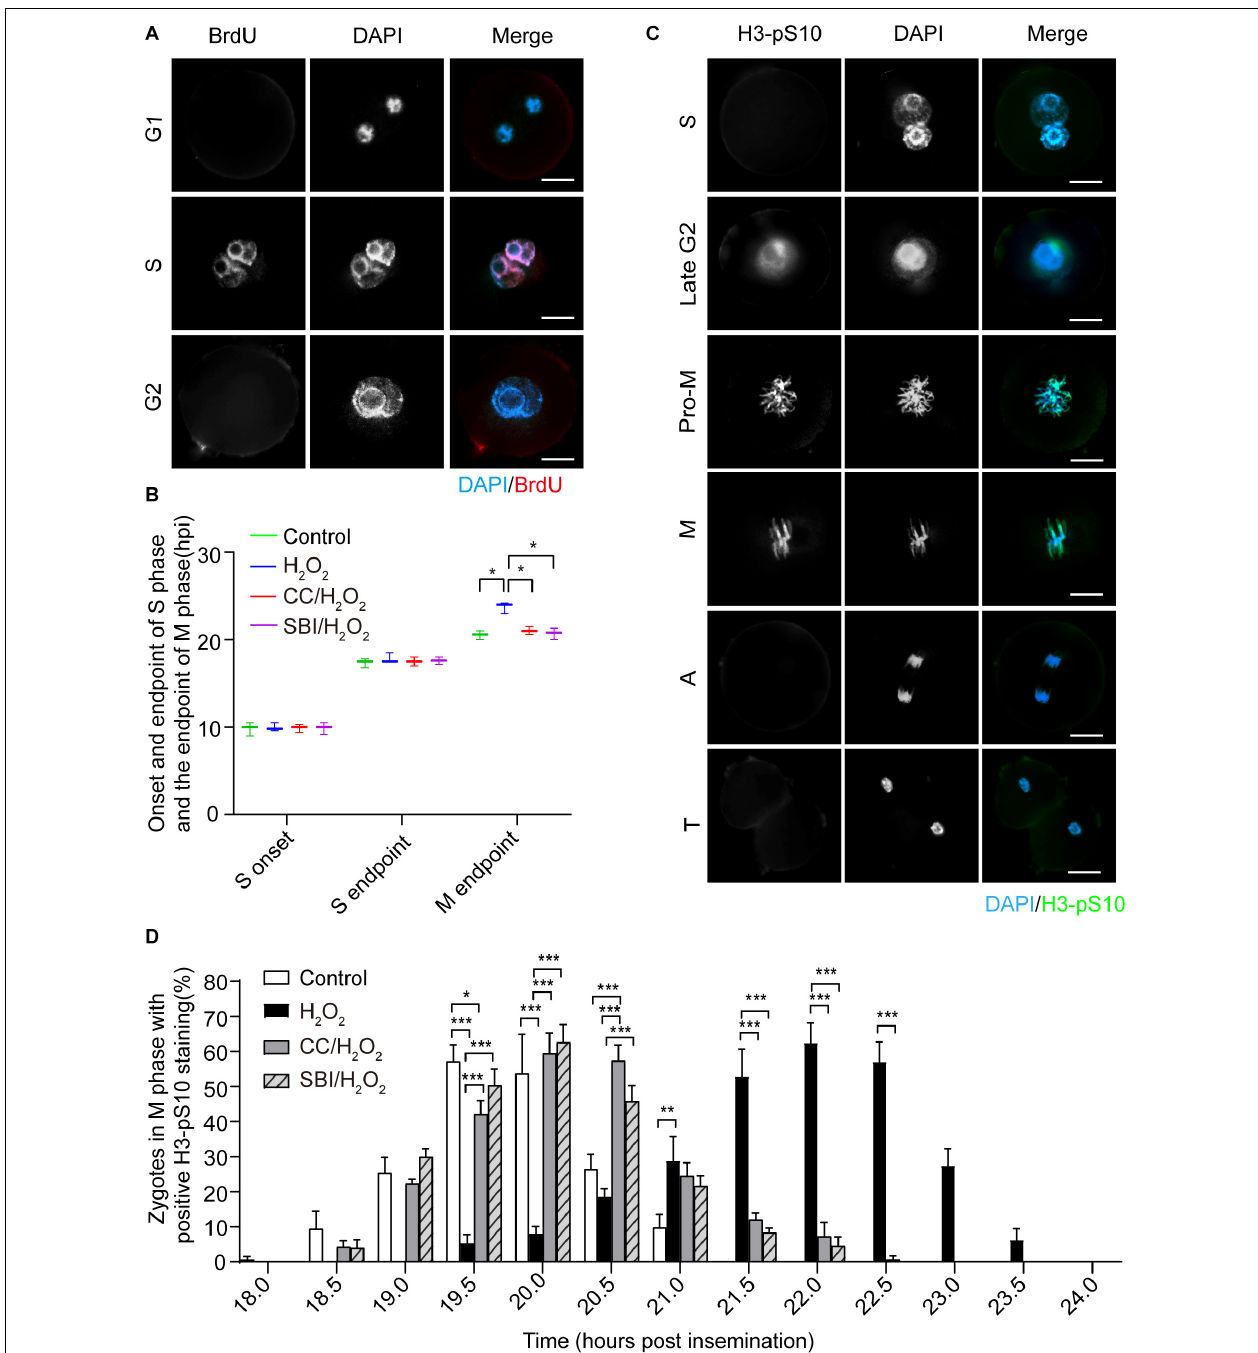
FIGURE 3 | Oxidative stress induced a delay of mitosis entry in mouse zygotes. (A) BrdU signal (red) was positive in the S phase and negative in the G1 and G2 phases and nuclei were stained with DAPI (blue). Scale bar = 20 µ m. (B) Determination of the onset and endpoint in the S phase and endpoint in the M phase of mouse zygotes. The onset and endpoint of the S phase were determined by BrdU incorporation. More than 60 zygotes per group were analyzed at each time point in each experiment ( n = 3). The endpoint of the M phase was determined by detecting when zygotes divided. More than 150 zygotes were analyzed in each experiment ( n = 3). CC, Compound C; SBI, SBI-0206965; hpi, hours post-insemination. (C) H3-pS10 signal (green). Nuclei were stained with DAPI (blue). Pro-M, M, A, and T refer to prometaphase, metaphase, anaphase, and telophase, respectively. Scale bar = 20 µ m. (D) Percentage of zygotes with positive H3-pS10 staining in control, H 2 O 2 -treated, Compound C/H 2 O 2 -treated (CC/H 2 O 2 ), and SBI-0206965/H 2 O 2 -treated (SBI/H 2 O 2 ) zygotes from 18 to 24 hpi. More than 45 zygotes per group were immunostained and analyzed at each time point in each experiment ( n = 3). Results in (B,D) were analyzed by one-way ANOVA and Tukey’s test. * p < 0.05; ** p < 0.01; *** p < 0.001. Error bars: SD.